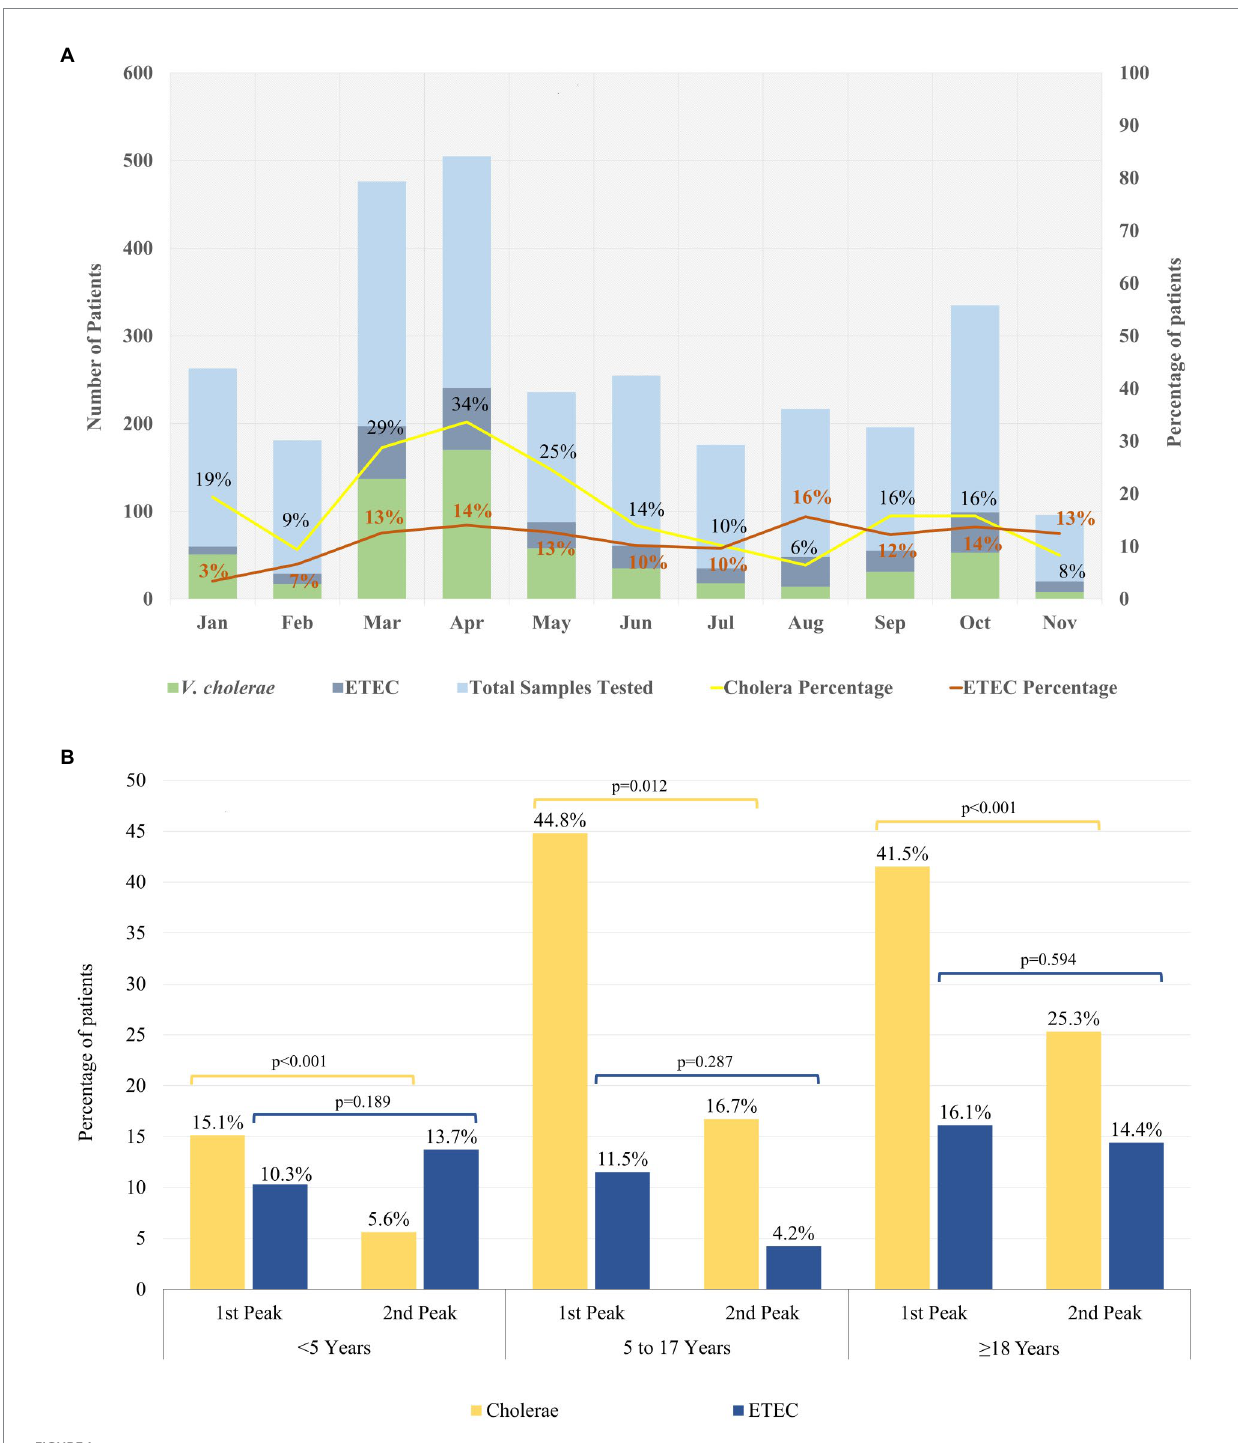
FIGURE 1 Distribution of ETEC and Cholera in 2022. (A) Month wise trend of ETEC and Cholera in 2022. (B) Age wise distribution of ETEC and Cholera cases during the biannual peaks in 2022. Chi square test at 5% level of significance was done to identify significant differences between the peaks within the different age